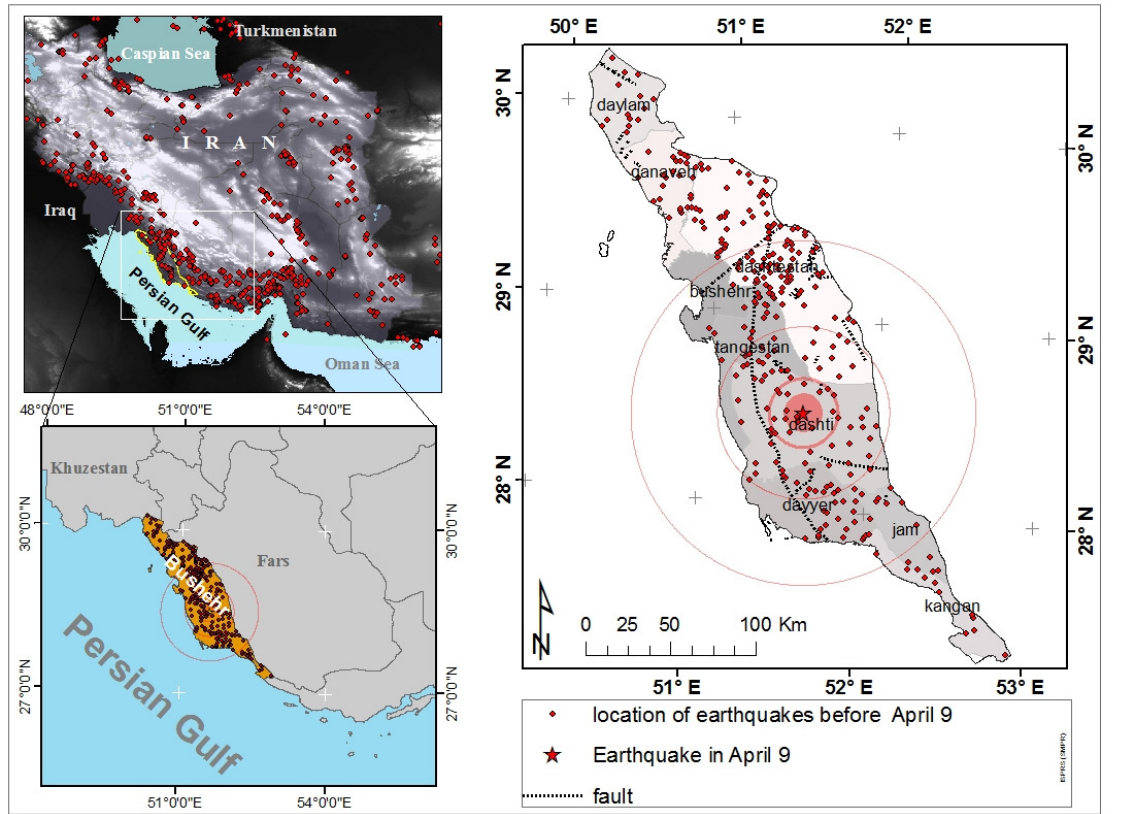
Figure 1: The figure illustrates position of the study area. The upper left map represents distribution of the earthquakes with magnitude greater than 5 Ms from 1973 to 2013 in physical terrain of Iran. The lower left map shows the location of Bushehr Province. The right map is an illustration of Bushehr Province as the study area and the exact location of the devastating earthquake of April 9 in the center of the concentric circles and also the location of all recorded earthquakes happened before 1973 in the